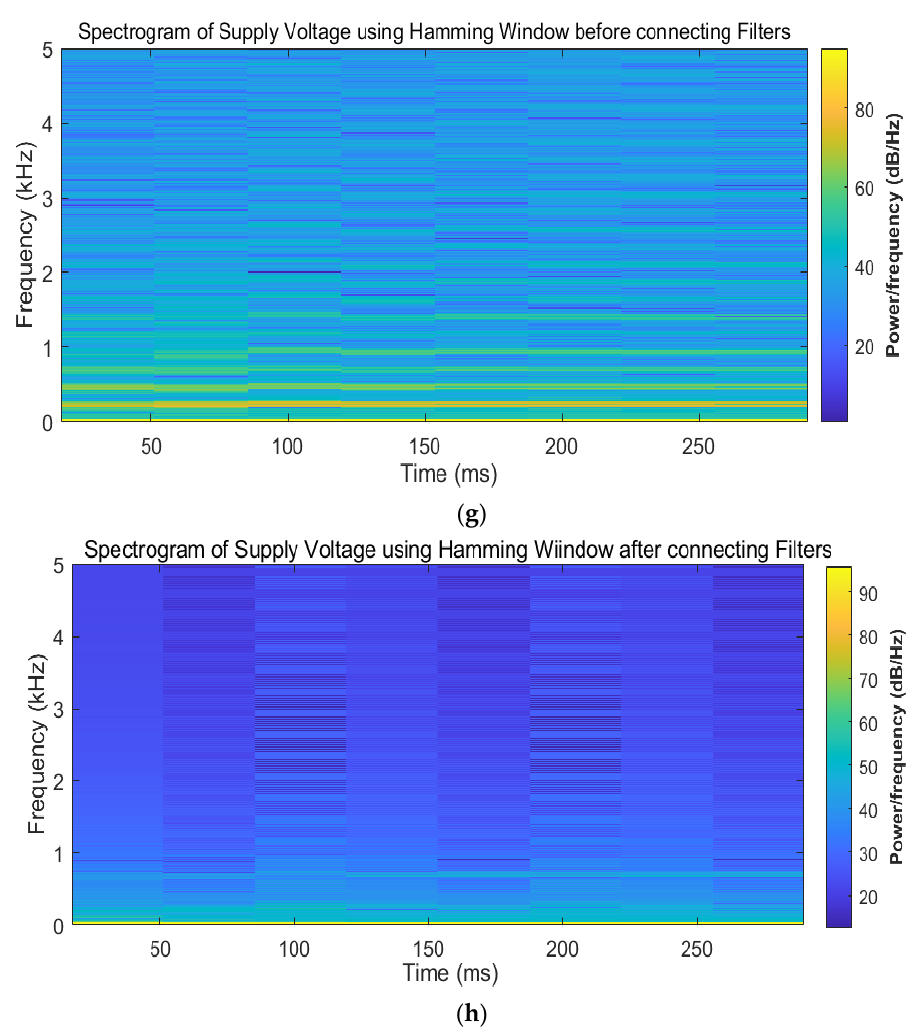
Figure 8. ( a ) Supply voltage before connecting harmonic filters. ( b ) Supply voltage after connecting harmonic filters. ( c ) Spectrogram of supply voltage before connecting harmonic filters using a Black- man window. ( d ) Spectrogram of supply voltage after connecting harmonic filters using a Blackman window. ( e ) Spectrogram of supply voltage before connecting harmonic filters using a Kaiser window. ( f ) Spectrogram of supply voltage after connecting harmonic filters using a Kaiser window. ( g ) Spectrogram of supply voltage before connecting harmonic filters using a Hamming window. ( h ) Spectrogram of supply voltage after connecting harmonic filters using a Hamming window.